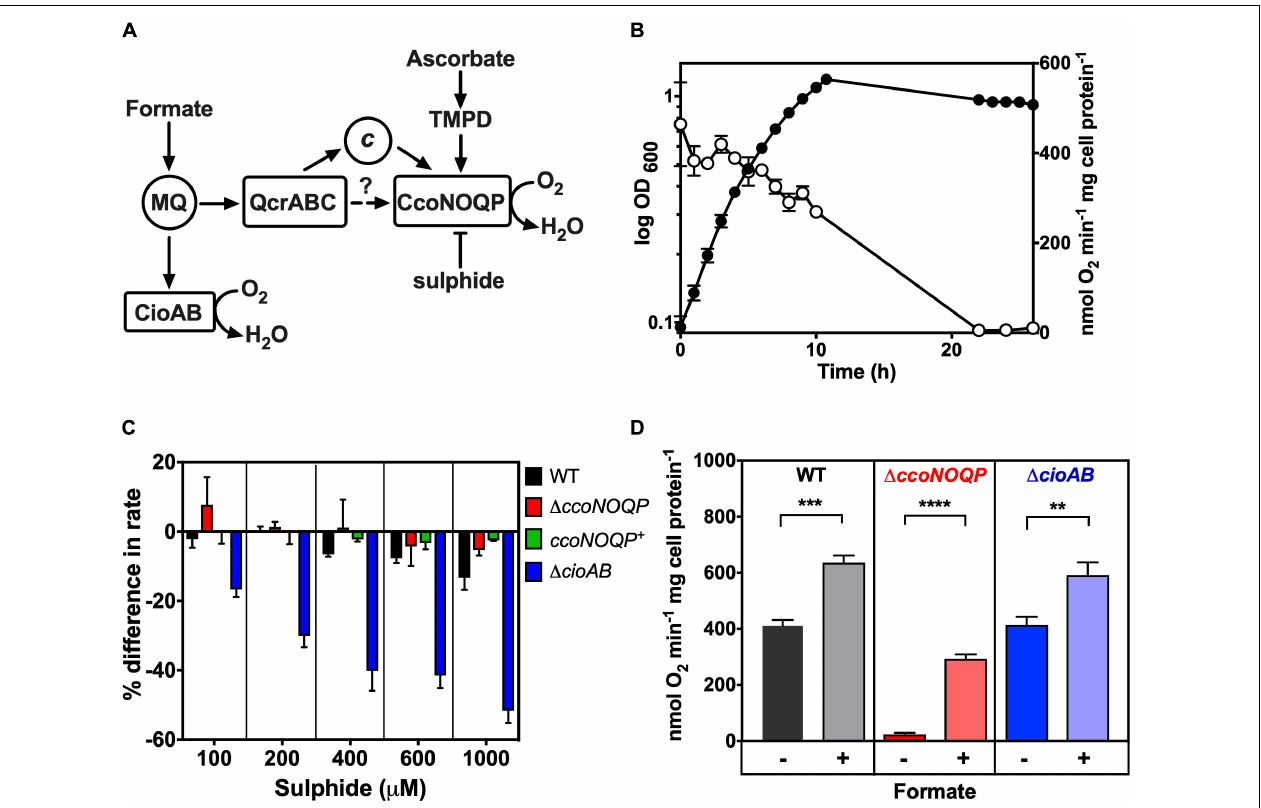
FIGURE 1 | Characterisation of cytochrome c oxidase activity in Campylobacter jejuni . (A) Simplified schematic of electron transport pathways to oxygen. Formate is a major physiological electron donor to the menaquinone (MQ) pool, where electrons can be directed either to the quinol oxidase CioAB or to the QcrABC complex and on to the cbb 3 -type cytochrome c oxidase CcoNOQP. Ascorbate reduced TMPD specifically acts as a non-physiological electron donor to the CcoNOQP oxidase. Sulphide inhibits activity (—|) (B) Cco activity in wild-type cells grown in Mueller-Hinton medium at different stages of growth, measured as oxygen uptake in a Clark type electrode with ascorbate plus TMPD as electron donor. The data points show the mean rate of three independent experiments with the errors bars showing SD. In many cases the error bars are too small to be seen. Closed circles, OD measured at 600 nm; open circles, specific rate of ascorbate/TMPD driven oxygen uptake. (C) Effect of increasing sulphide concentrations on the rate of ascorbate/TMPD oxidase activity in wild-type (black bars), ccoNOQP deletion mutant (red bars), ccoNOQP complemented strain ( ccoNOQP + ; green bars) and cioAB mutant (blue bars). The results are shown as the mean% difference in the rate compared to the rate without any sulphide addition. Error bars show SD from three independent experiments. (D) Cco activity measured with ascorbate/TMPD without ( − ) and with ( + ) 20 mM sodium formate in the assay. Wild type (black bars), (cid:49) ccoNOQP (red bars) and (cid:49) cioAB (blue bars) cells were grown to mid-exponential phase in Mueller-Hinton medium. The data are the average of triplicate cultures with error bars showing SD. Student’s t -tests were performed to test significance (0.01 > ** p > 0.001; 0.001 > *** p > 0.0001; 0.0001 > **** p > 0.00001). Raw data for Figures 1 – 7 can be found in Supplementary Tables 1, 2